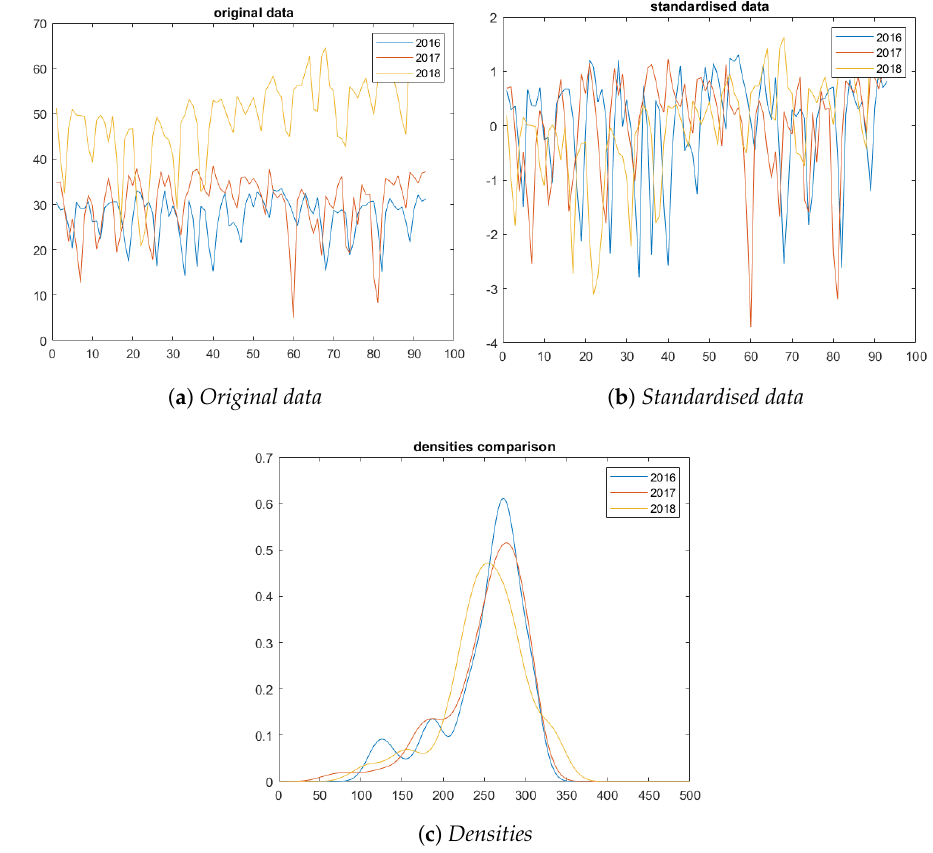
Figure 8. Behaviour of data and their